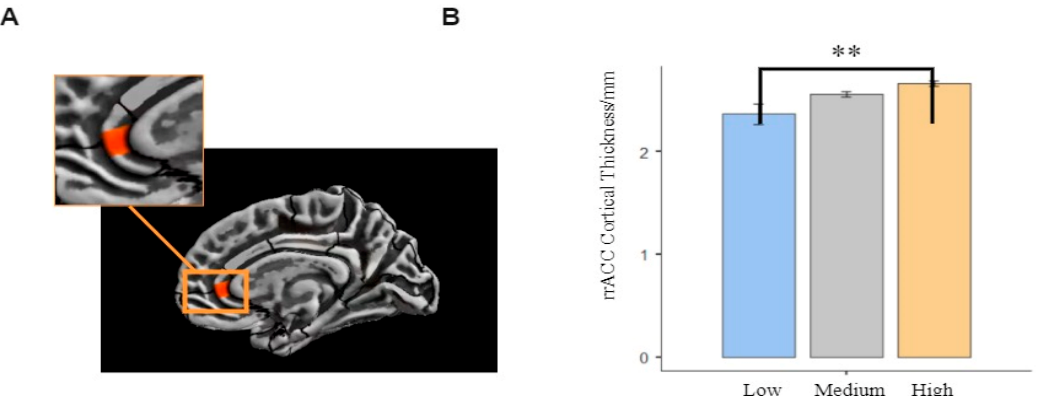
Figure 2. ( A ) Distinct regions that exhibited differences in cortical thickness (rostral anterior cingulate of right region) between high and low PA groups. ( B ) Surface-based morphometry results of cortical thickness in the three groups. Surface-based morphometry results after multiple comparisons correction. Note: ** Denotes significant differences at p < 0.01.